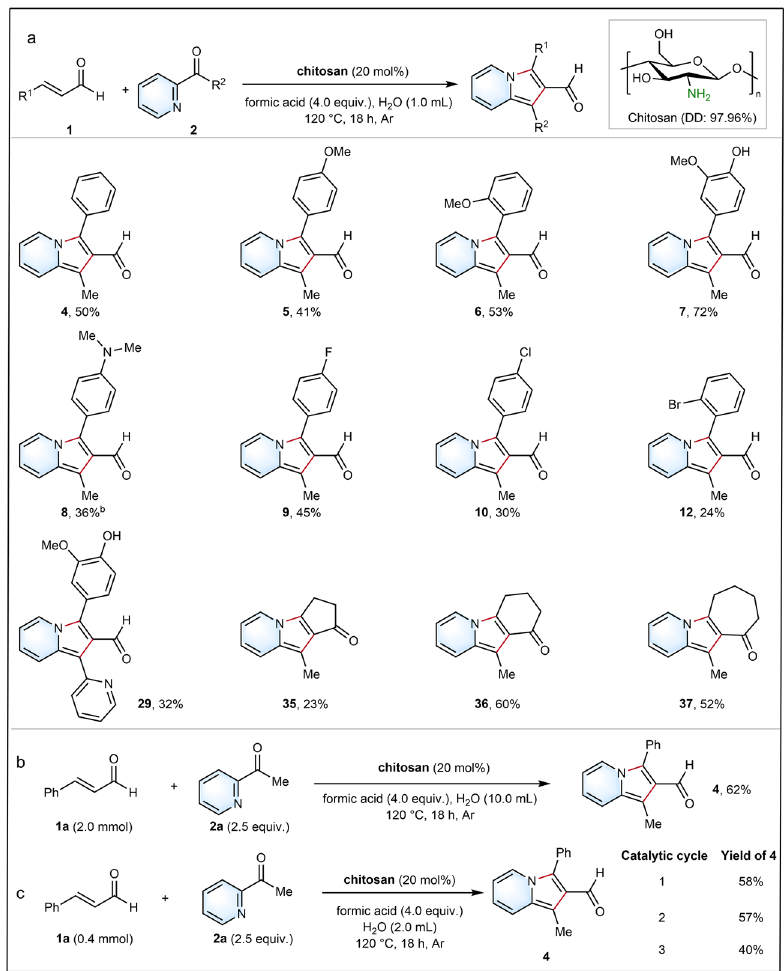
Fig. 5 Chitosan as stereoauxiliary aminocatalyst for indolizine-2-carbaldehydes via [3 + 2] annulation. a Scope of substrates. a General procedure E : α , β - unsaturated aldehydes/ketones (0.2 mmol), heteroaryl ketones (2.5 equiv.), chitosan (20 mol%) and formic acid (4.0 equiv.) in H 2 O (1.0 mL) for 18 h at 120 °C under Ar atmosphere. b General procedure F : α , β -unsaturated aldehydes/ketones (0.2 mmol), heteroaryl ketones (2.5 equiv.), and chitosan (20 mol %) in Formic acid : H 2 O (0.5 : 0.5 mL) for 36 h at 120 °C under Ar atmosphere. b Larger scale synthesis of indolizine-2-carbaldehyde. c Cycling catalytic experiments for the synthesis of